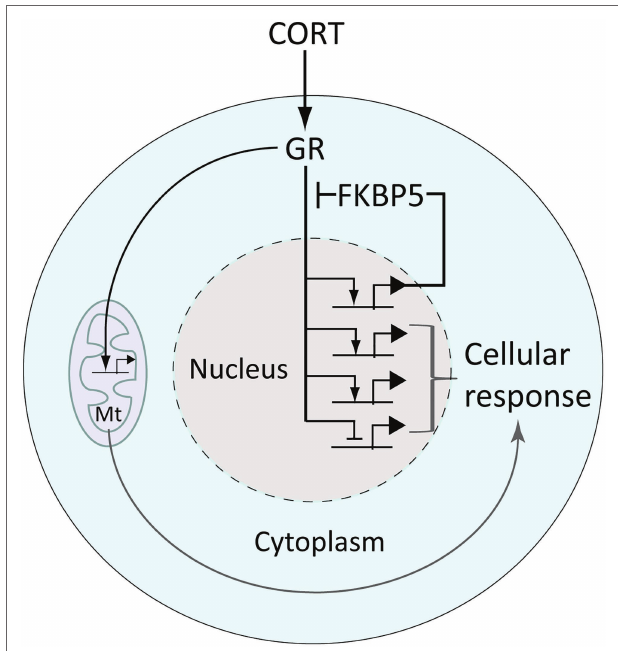
FIGURE 2 | The glucocorticoid receptor (GR) regulates gene expression and the cellular response to glucocorticoid signaling. CORT diffuses freely into cells wherein it binds the GR, releasing it from a chaperone complex (which includes the protein Fkbp5) that anchors it in the cytoplasm. CORT-activated GR translocates into the nucleus, wherein it regulates the transcription of genes bearing glucocorticoid-response elements (which include fkbp5 ) or via tethering to other transcription factors. Activated GR also enters and regulates gene activity within mitochondria (Mt). These gene regulatory effects combine to produce a cellular response to CORT, for example, metabolic